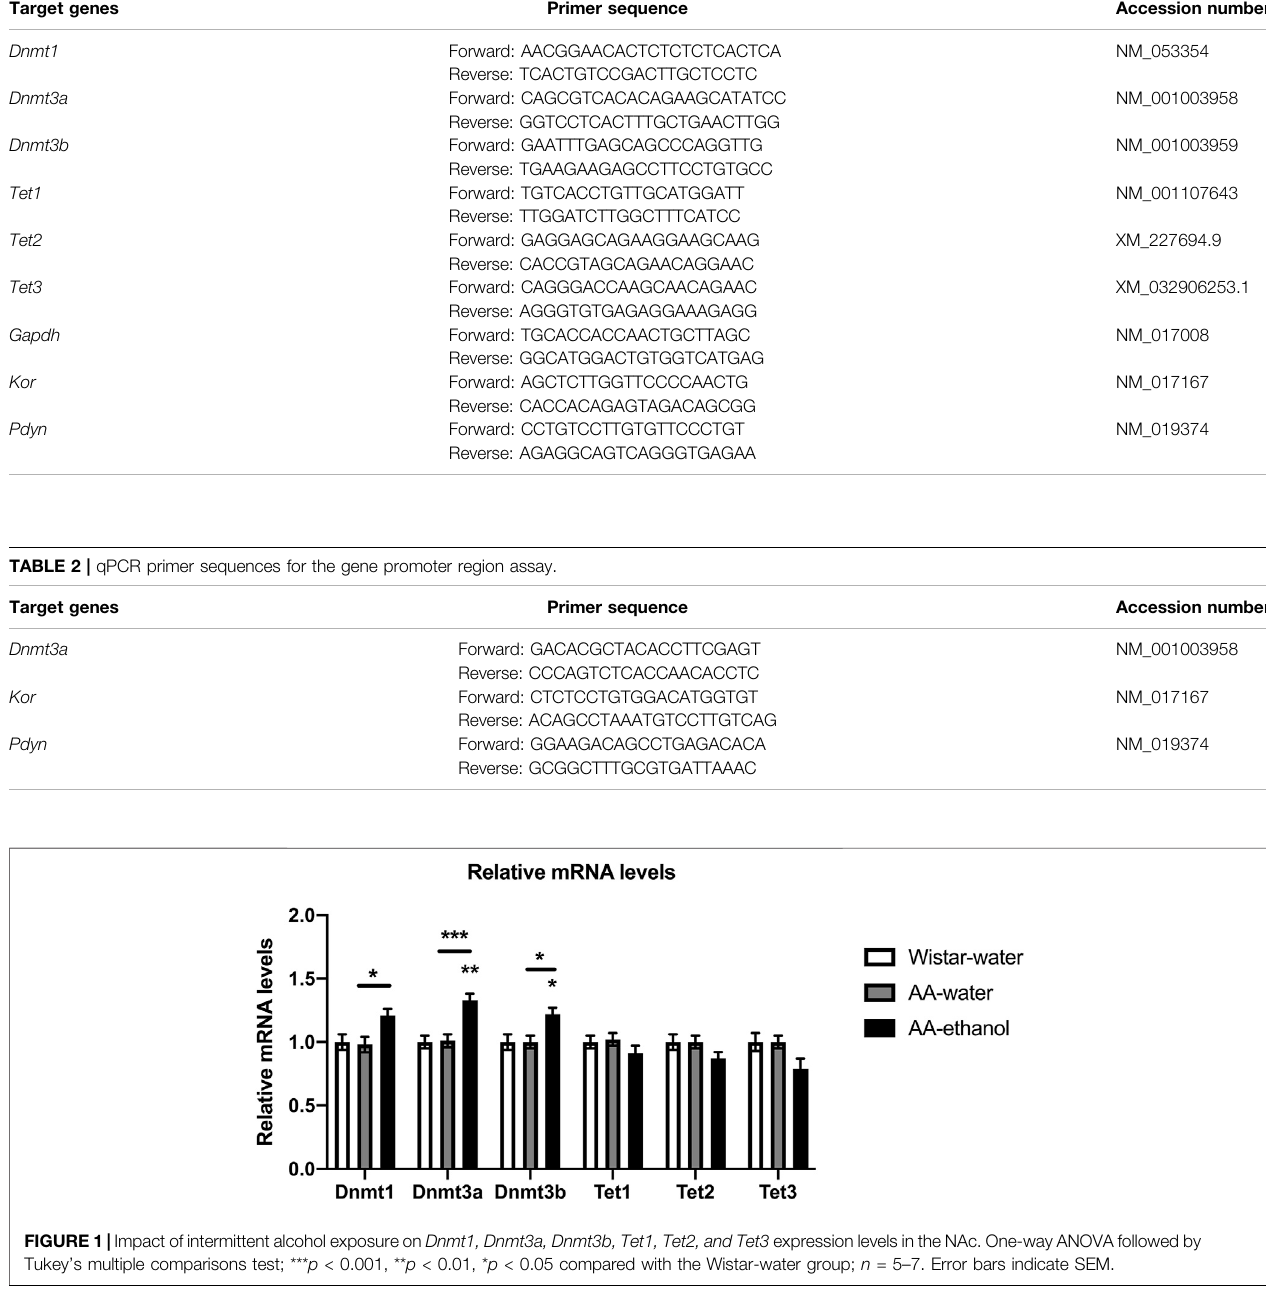
Table 2 . The percentages of the 5hmC, 5mC, and cytosine of the inner C at the site-speci fi c CCGG were calculated using the EpiMark comparative C t method.